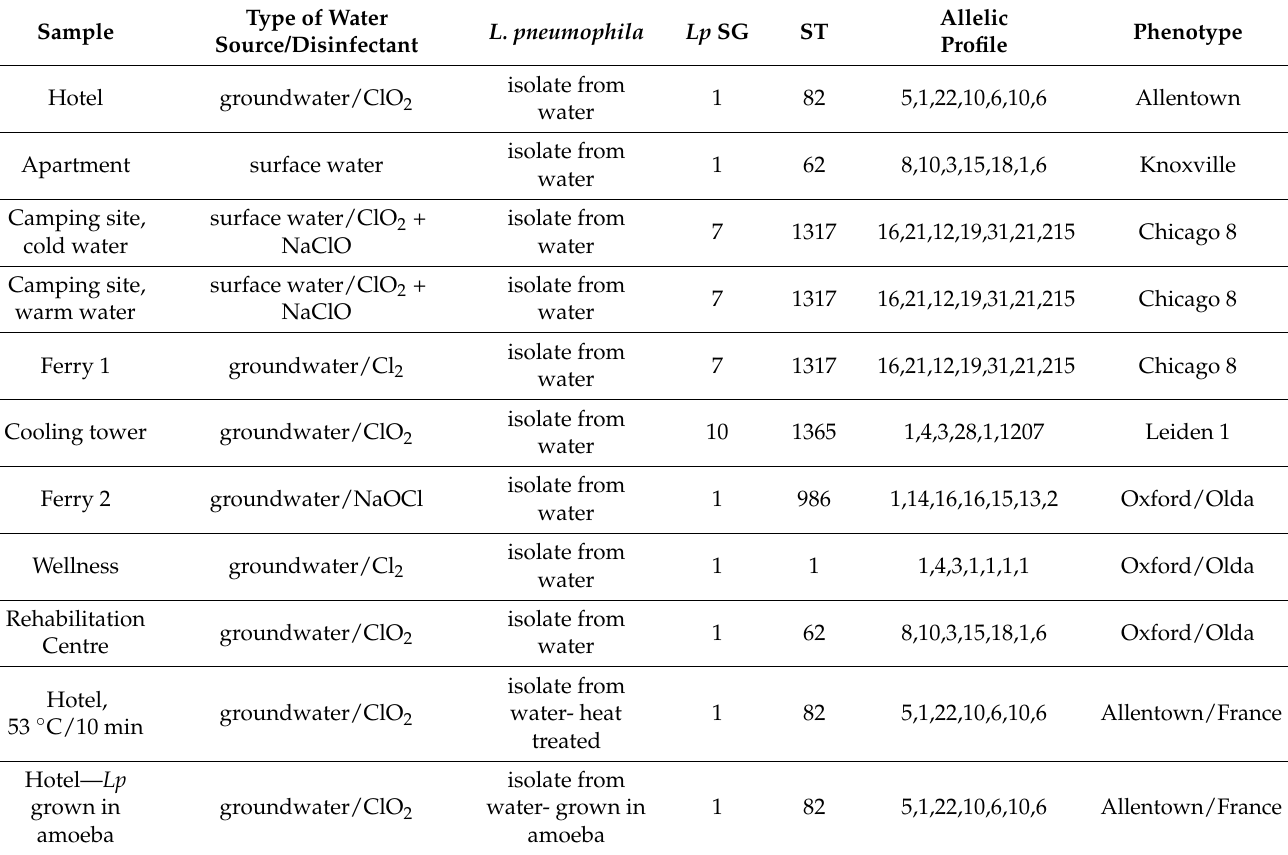
Table 2. Serogroups, STs, allelic profiles, and phenotypes of the L. pneumophila environmental samples isolated in the Primorje-Gorski Kotar County